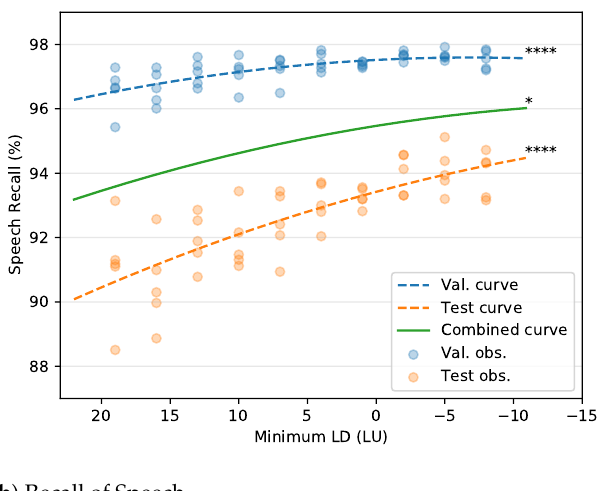
Figure 8. Evaluation of different values for minimum LD. The maximum LD was fixed at 21 LU. Validation observations (Val. obs.) and test obs. are the actual values obtained in experiments. The val. and test curves were generated through quadratic curve fitting. The combined curve aggregates the observations on val. and test set for quadratic curve fitting. ANOVA was performed on the observations and the asterisks indicate the level of significance (*: p < 0.05, **: p < 0.01, ***: p < 0.001, ****: p <